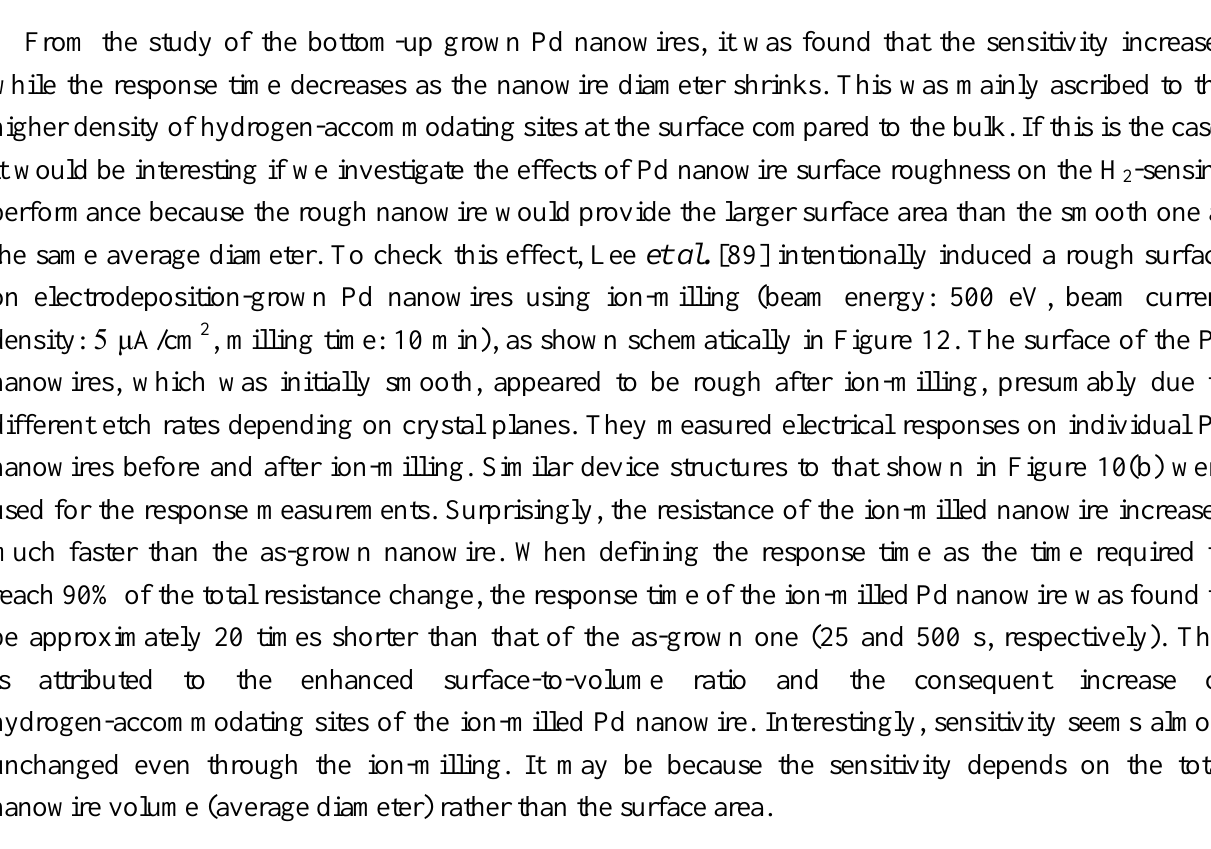
Figure 12. Schematic illustration of the rough surface of Pd nanowires induced by